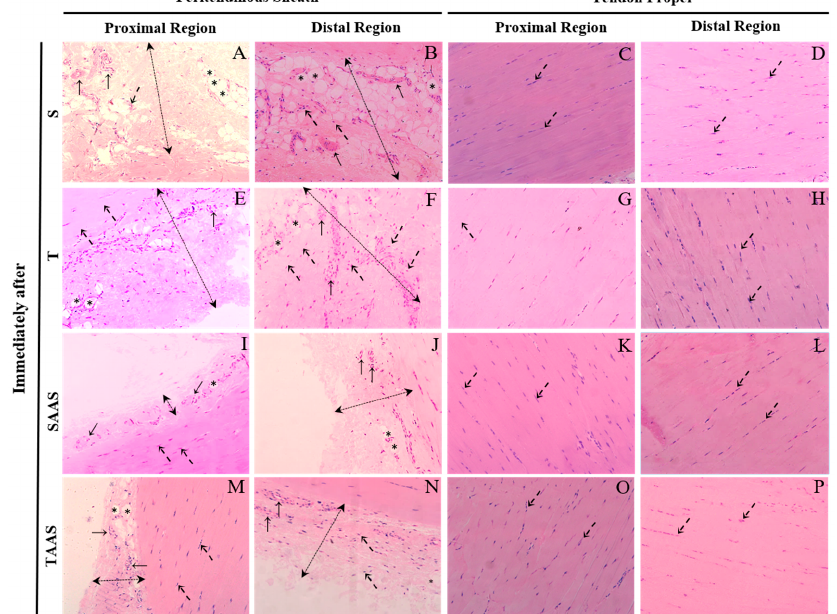
Figure 3. Longitudinal sections of the proximal and distal regions of the CT in the IA group stained with hematoxylin-eosin. Sedentary subgroup ( S ): In the peritendinous sheath (dashed double-head arrow), the proximal ( A ) and distal ( B ) regions show blood vessels (arrows), cells (dashed arrows), and adipose cells (asterisks). In the tendon proper, the proximal ( C ) and distal ( D ) regions show cells (dashed arrows). Trained subgroup ( T ): In the peritendinous sheath (dashed double-head arrow), the proximal ( E ) and distal ( F ) regions show blood vessels (arrows), cells (dashed arrows), and adipose cells (asterisks). In the tendon proper, the proximal ( G ) and distal ( H ) regions show cells (dashed arrows). Sedentary with AAS administration ( SAAS ): In the peritendinous sheath (dashed double-head arrow), the proximal ( I ) and distal ( J ) regions show blood vessels (arrows), cells (dashed arrows), and adipose cells (asterisks). In the tendon proper, the proximal ( K ) and distal ( L ) regions show cells (dashed arrows). Trained with AAS administration ( TAAS ): In the peritendinous sheath (dashed double-head arrow), the proximal ( M ) and distal ( N ) regions show blood vessels (arrows), cells (dashed arrows), and adipose cells (asterisks). In the tendon proper, the proximal ( O ) and distal ( P ) regions show cells (dashed arrows). Original magnification, 400 × . Scale bars 20 µ